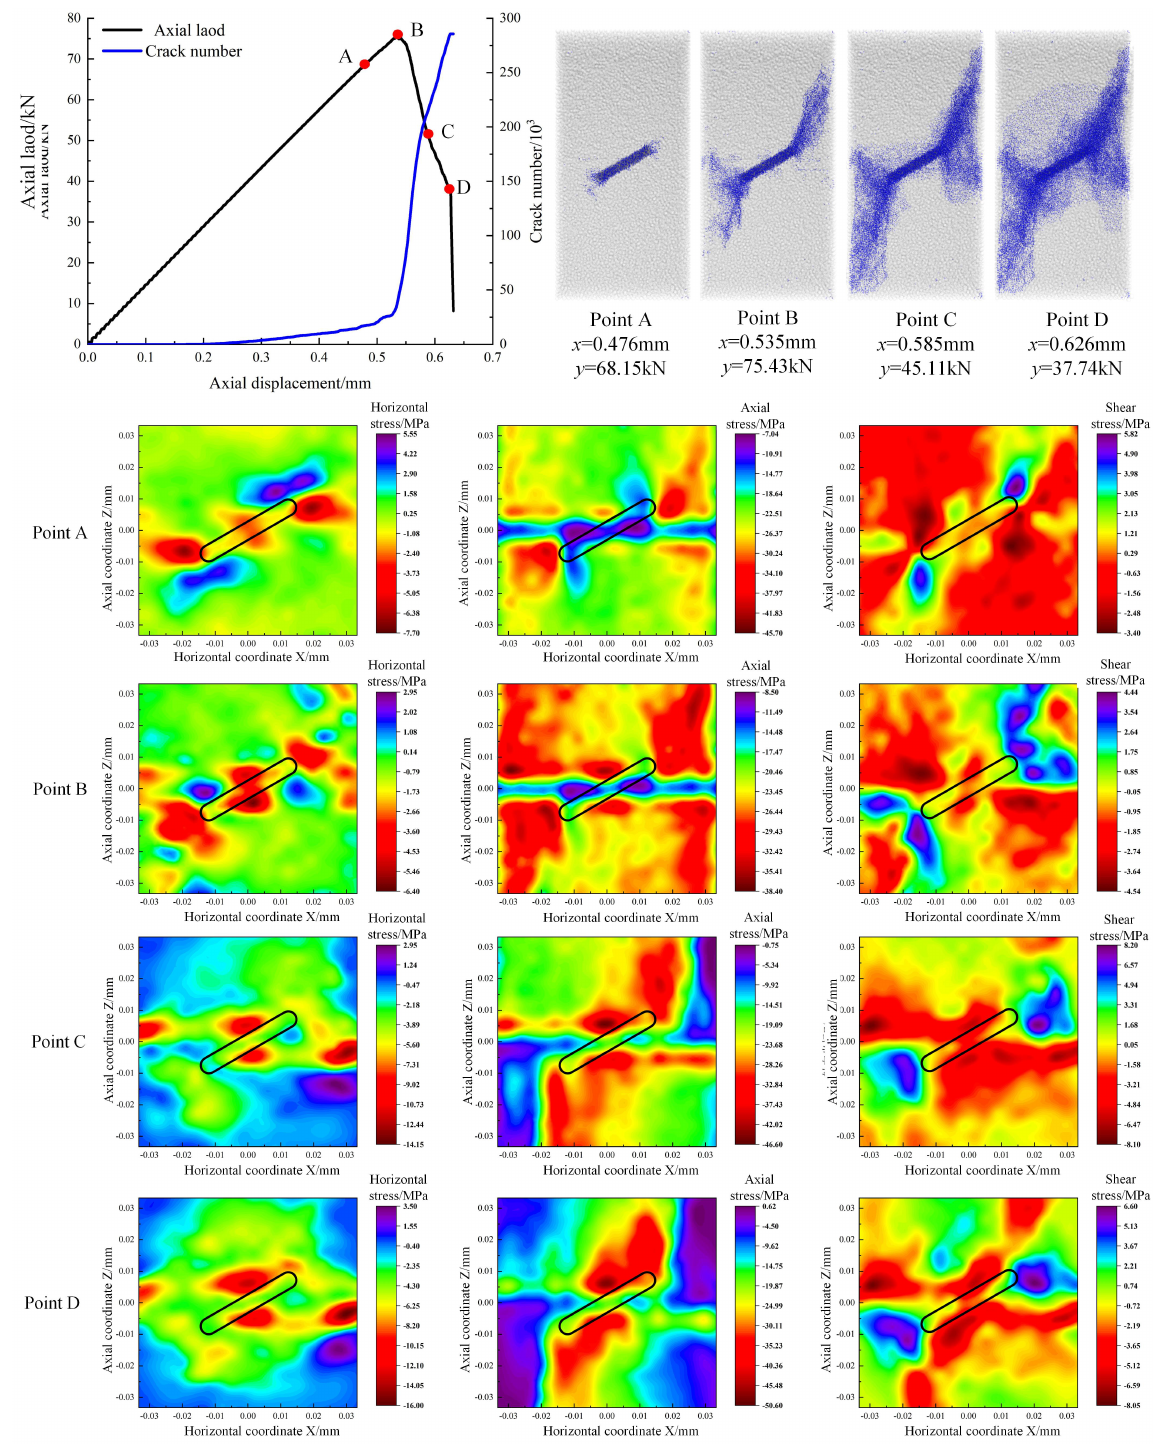
Figure 19. Crack propagation and stress evolution of R-30 sample. From point A to point D, the shear stress had a larger value in the internal weak interlayer, while the larger value of the shear stress in the F-30 sample only existed on the surface of the weak interlayer. The restrained-ends anchorage effect led to complete